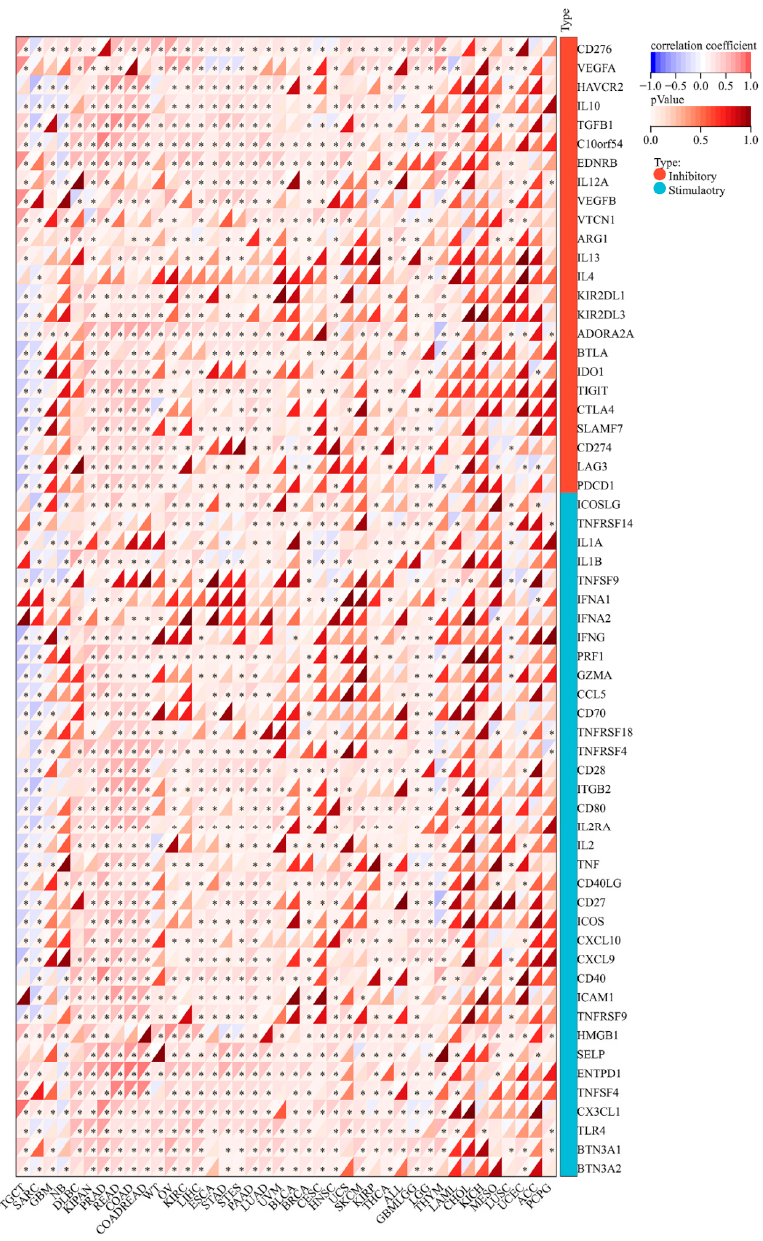
Figure 6. The correlation matrix between MEIS1 expression and ICPG expressions. * p < 0.05.